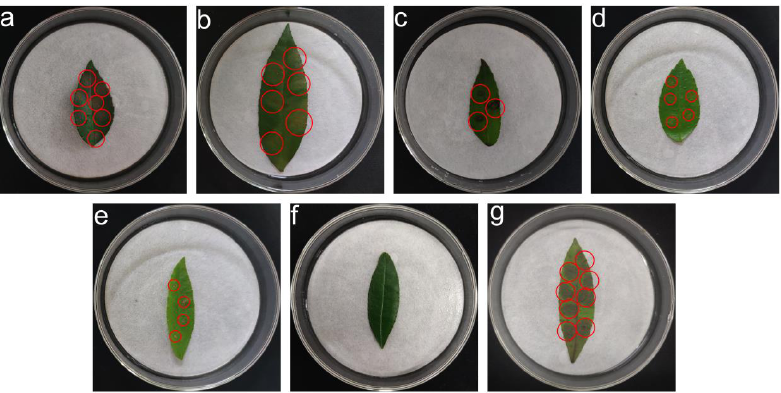
Figure 10. Pathogenicity test results of 100 µ g/mL treatment. ( a ) 3,5-Dimethoxybenzoic acid; ( b ) S - (5-adenosy)- L -homocysteine; ( c ) 2-(1 H -indol-3-yl)acetic acid; ( d ) L -glutamic acid; ( e ) 2-(2-acetyl-3,5-dihydroxy phenyl)acetic acid; ( f ) CK 1 : sterile water; ( g ) CK 2 (1 × 10 6 cfu/mL pathogen spore suspension is not photographed).The red circle marks the Table 3. Effects of different reagents and their concentrations on the lesion area of Z. schinifolium .